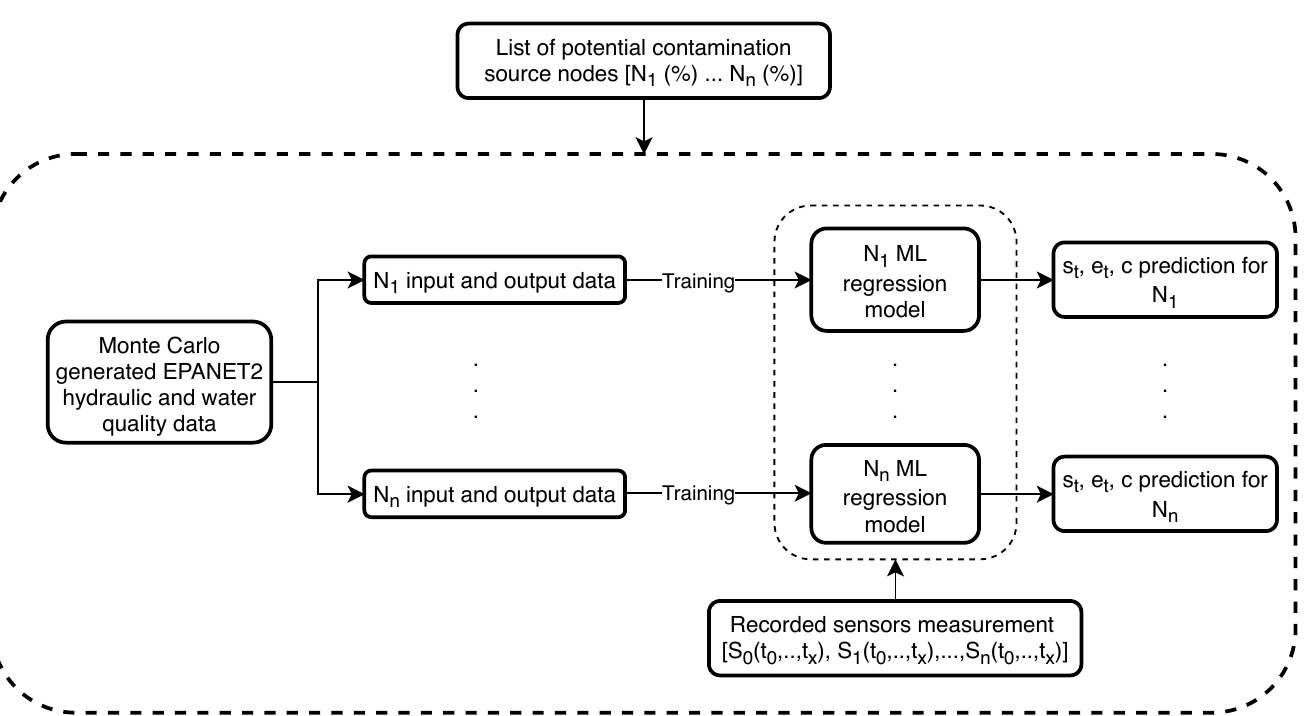
Figure 7. Machine learning regression model